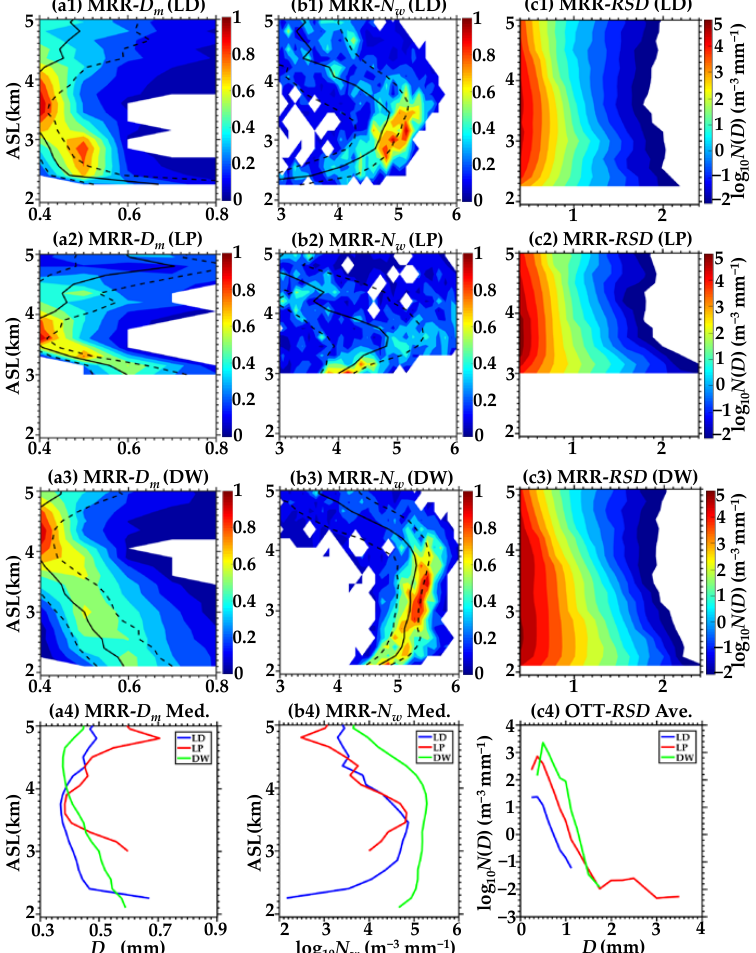
Figure 8. NCFADs of the mass-weighted mean diameter D m (mm) and the logarithm of the gener- alized intercept parameter log 10 N w (m −3 mm −1 ) for the shallow cloud and precipitation stage over ( a1 , b1 ) the LD, ( a2 , b2 ) LP, and ( a3 , b3 ) DW sites. Contours represent occurrence. The black dashed lines represent the 25th, 50th, and 75th percentiles, and ( a4 , b4 ) are median profiles of D m and log 10 N w over three sites. Vertical distribution of raindrop size distribution RSDs for the shallow cloud and precipitation stage over ( c1 ) LD, ( c2 ) LP, and ( c3 ) DW. Contours represent log 10 N(D) (m −3 mm −1 ), and ( c4 ) is averaged RSDs on the ground at LD, LP, and DW.